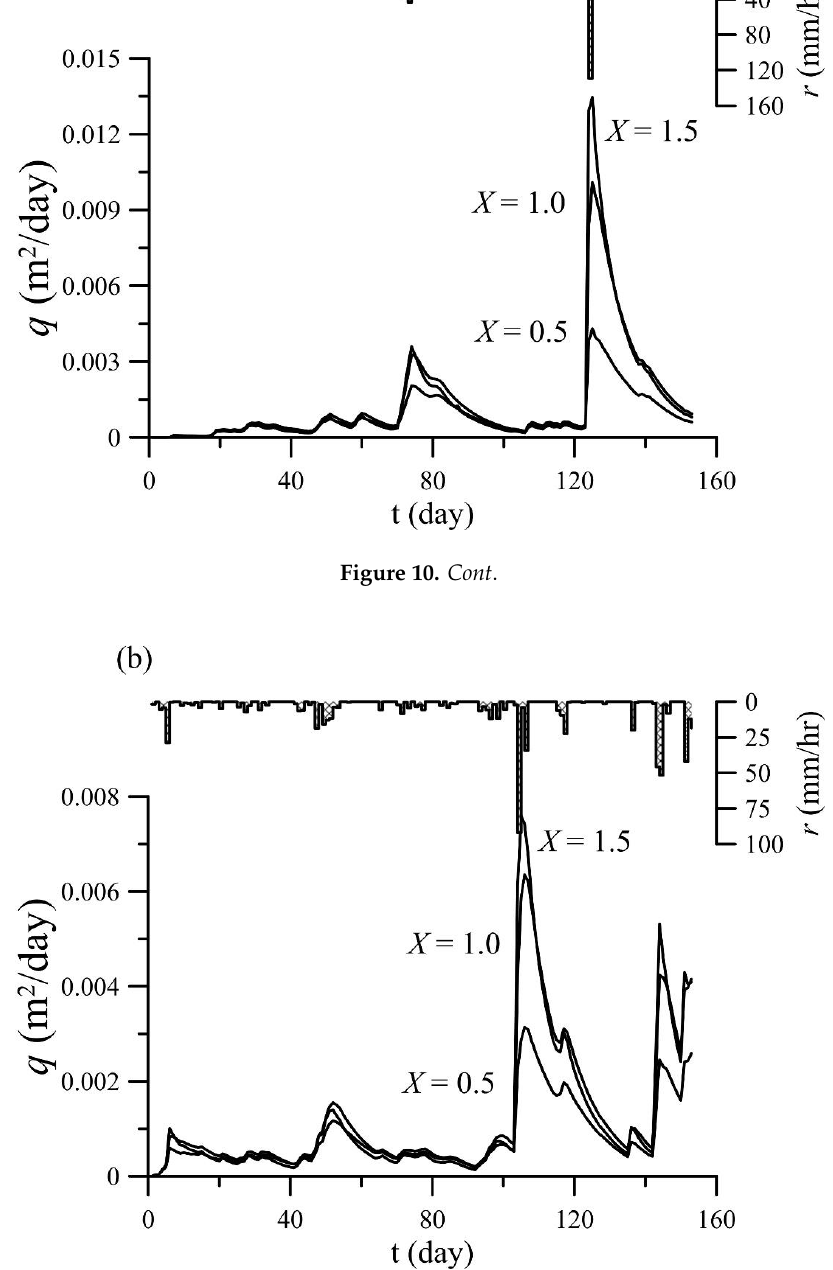
14 of 16 Figure 9. Variation of groundwater level due to time-varying recharge rate. The solid line denotes the simulated result of the present solution. The dashed line is the observed groundwater level at the Taichung Dali station in ( a ) 2012 ( 𝜀 = 0.3,ℎ 0 = 53.5 m,𝐷 = 80 m ), ( b ) 2013 ( 𝜀 = 0.3,ℎ 0 = 54.0 m,𝐷 = 80 m ), and ( c ) relative percentage difference (RPD) of simulation results and observational data.